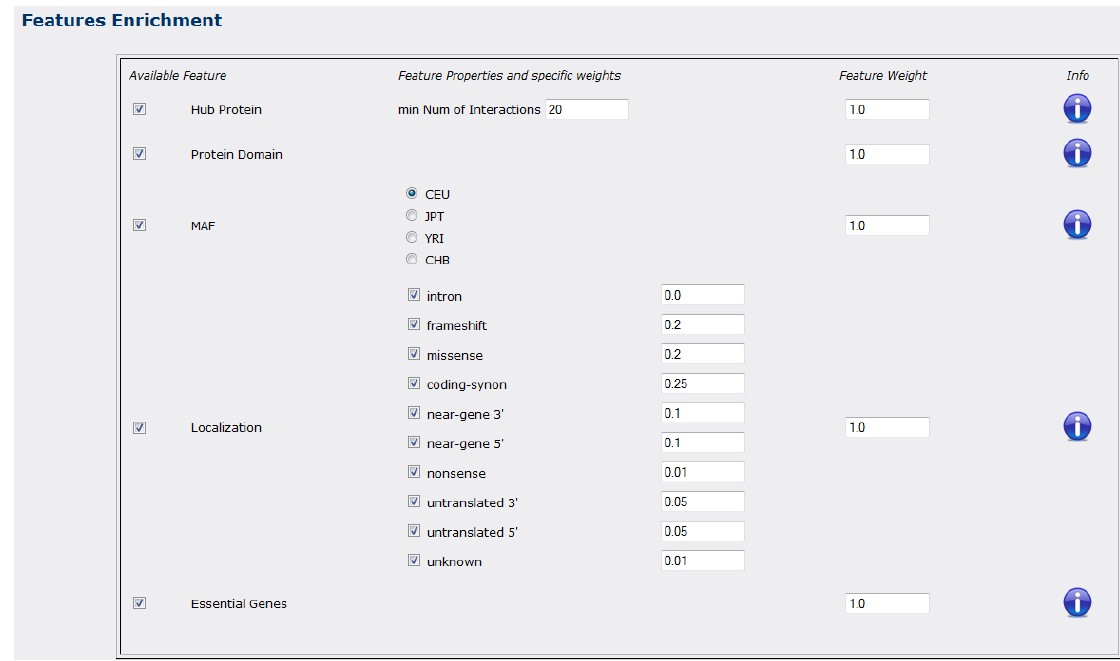
Figure 3: Screenshot from the web site. Features selection and weights values setting. top of it many “frameshift” and “missense” are concentrated. The latter localization types are only around the 3% of the whole set but SNPs in these positions obtained higher scores. De- scending the ranked list, SNPs occur that are localised in UTR regions and near the gene. The “unknown” value is important for covering other DNA